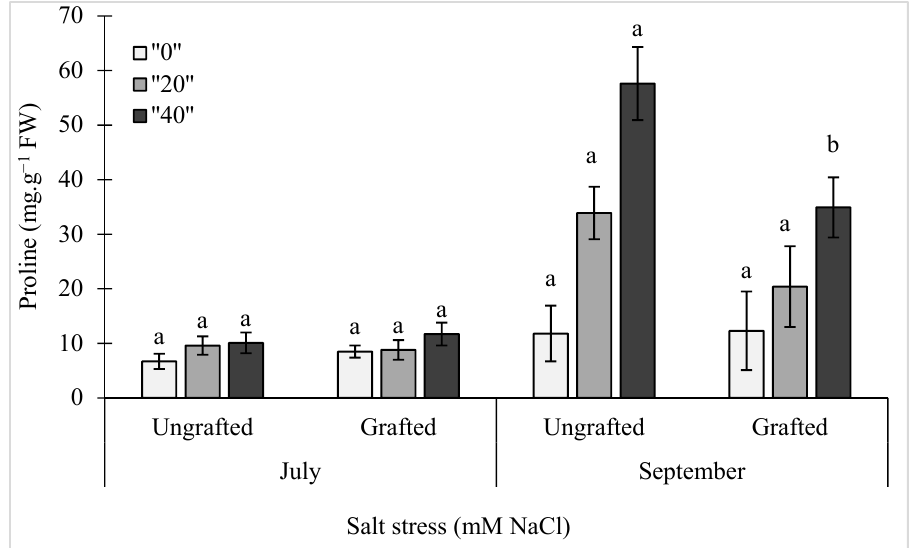
Figure 2. Effects of salt stress (0 mM, 20 mM, 40 mM NaCl) on proline content in the leaves of ungrafted and grafted bell pepper plants, as measured in July and September. Data are means ± standard deviation of three replicate samples (n = 3). Data with different lower case letters are significantly different (Duncan test).